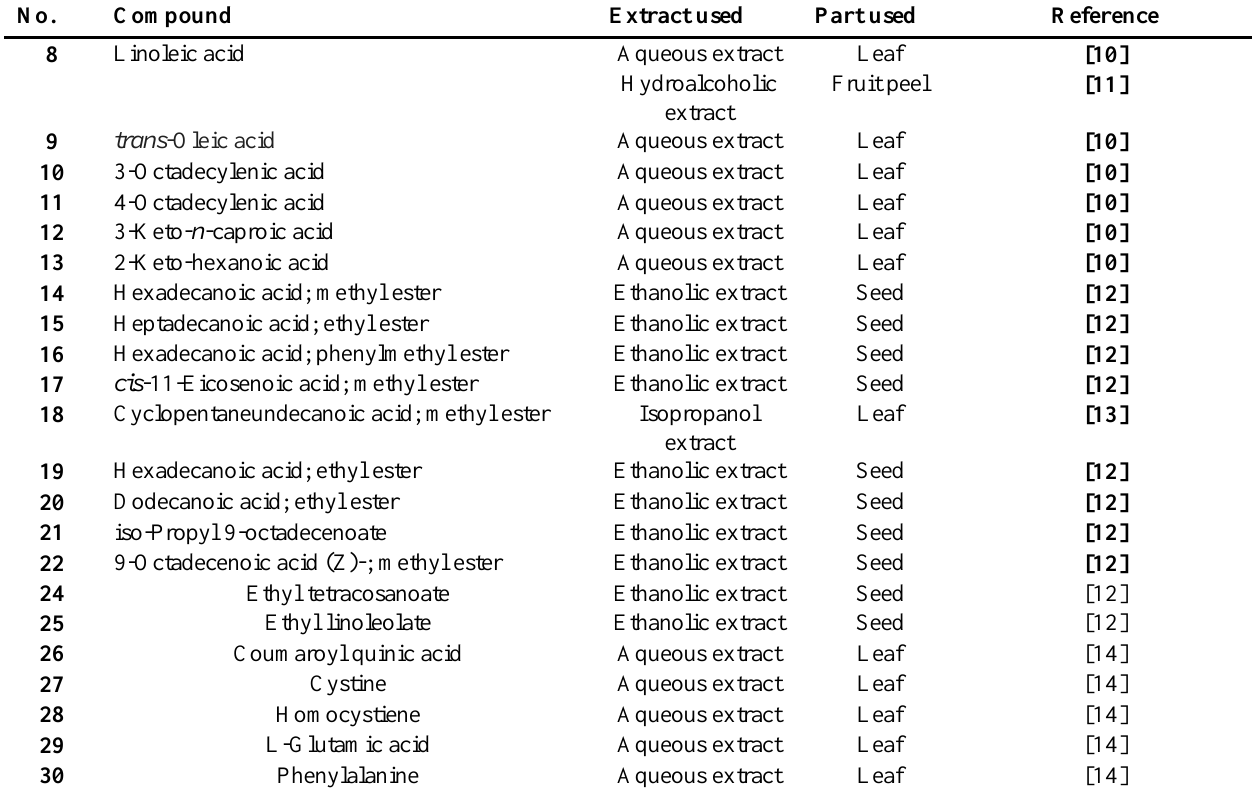
Table 2. Fatty acids, fatty acid esters, and amino acids reported in C. papaya